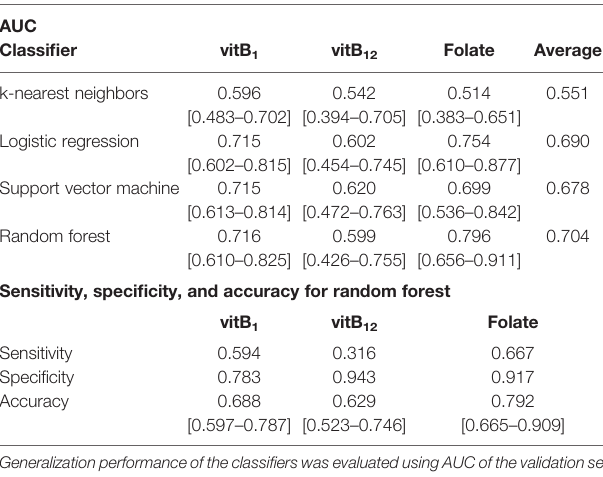
TABLE 4 | Summary of AUC, sensitivity, speci fi city, and accuracy for the validation